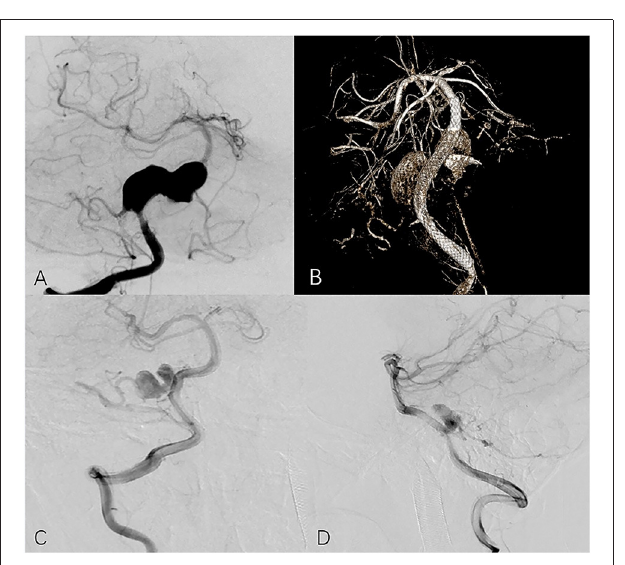
FIGURE 2 | Seventeen year-old male with right vertebral aneurysm extending to basilar artery. (A) Preoperative frontal angiogram shows a giant vertebrobasilar aneurysm involving PICA. (B) Postoperative DynaCT indicates good opening of the PED and apposition. The 13-month follow-up frontal (C) and lateral (D) angiogram shows the aneurysm is incompletely occluded and the PICA is preserved.